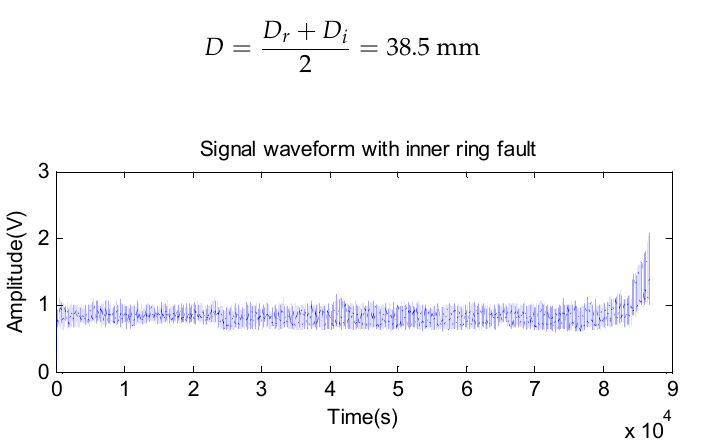
Figure 3. The waveform of wheel hub bearing signal.